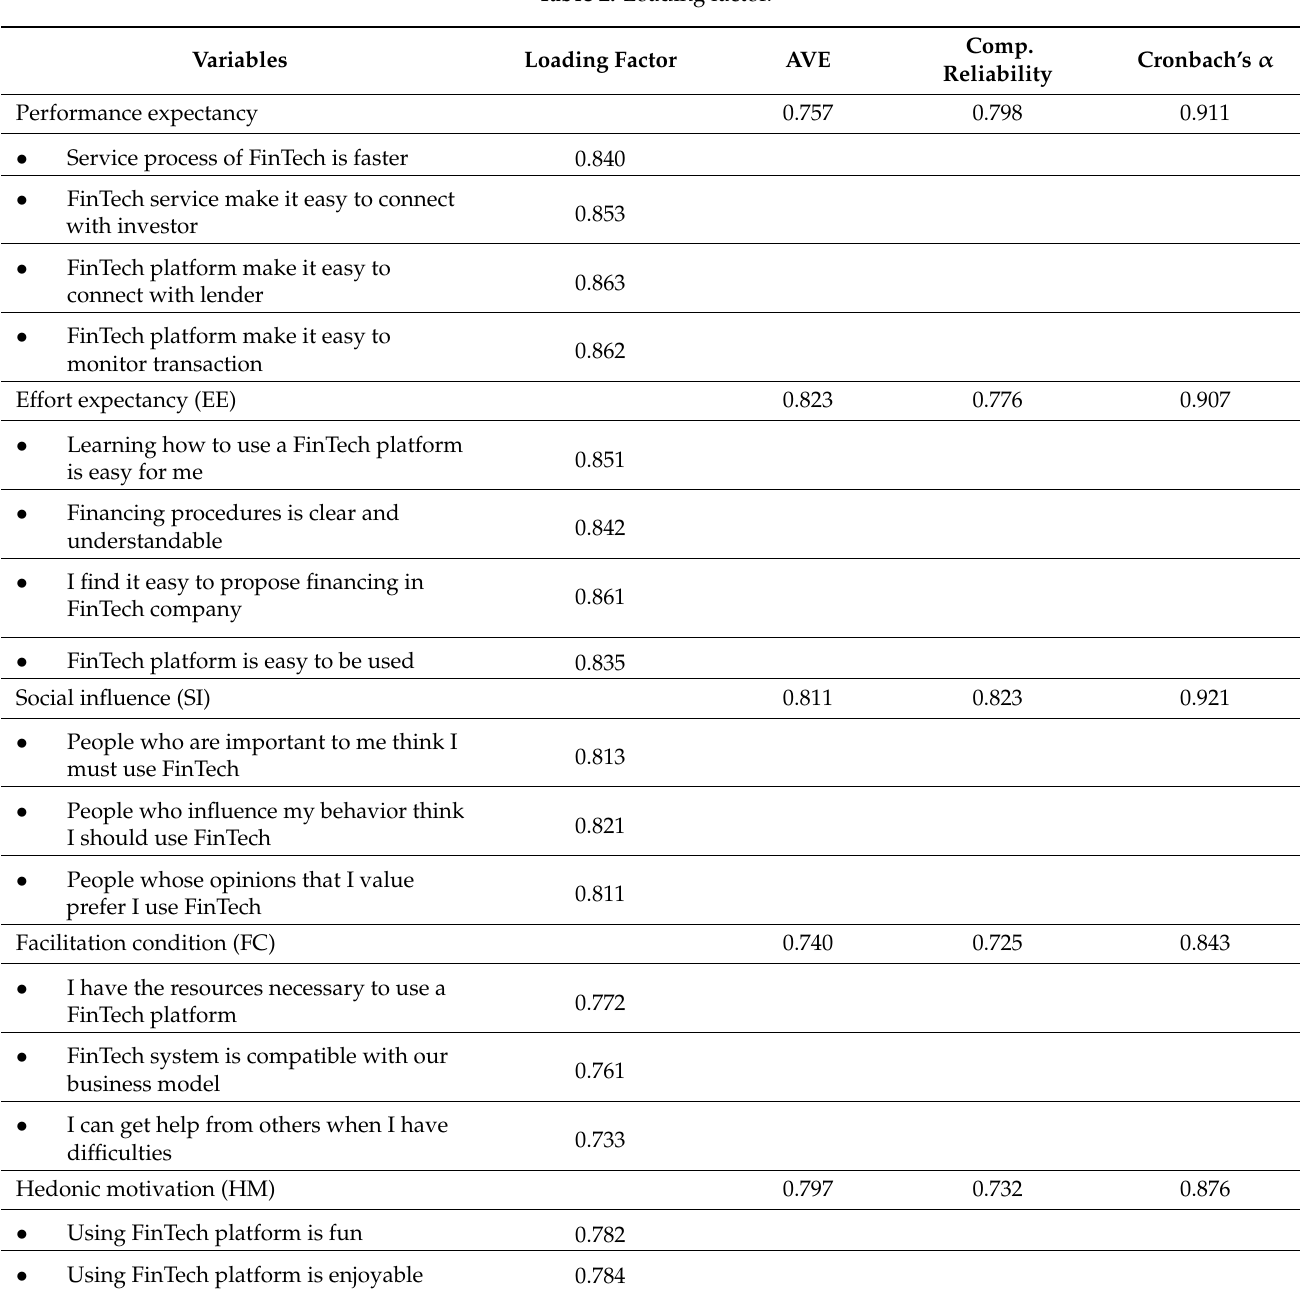
Table 2. Loading